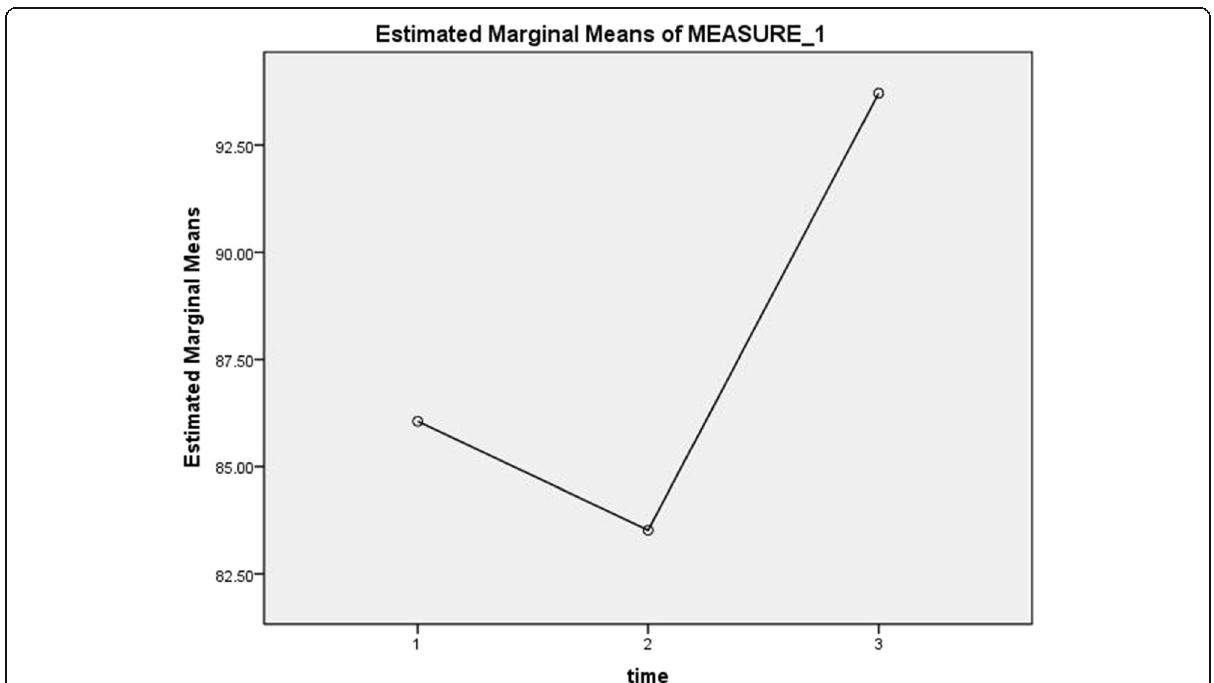
Fig. 1 Changes observed in PaO 2 over time. Hypoxemia was present at baseline and a further decrease was observed with nasal packing and significant improvement was detected after removal of nasal packs